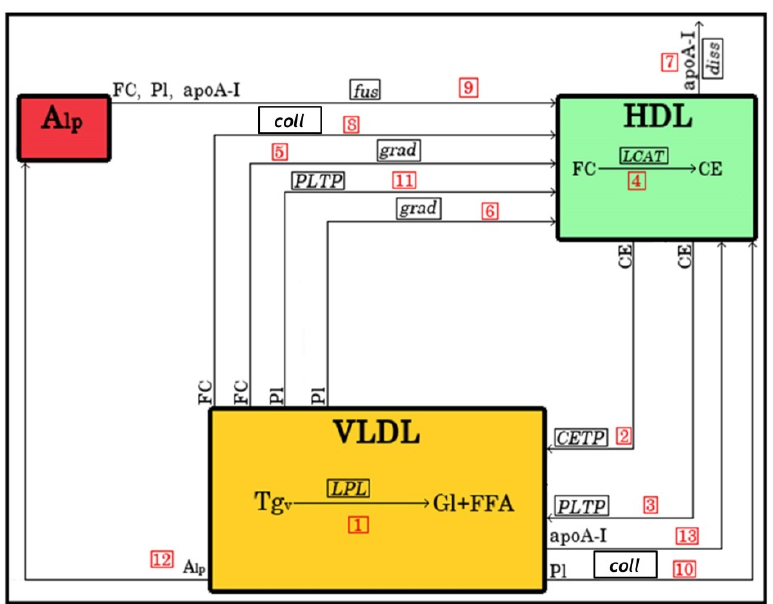
Figure 9. Schematic representation of the model of lipoprotein remodelling upon VLDL lipolysis by LPL in the presence of HDL. The arrows shown represent processes described in the text which are equally abbreviated in italics. The arrows are numbered according to the reaction numbers shown in Table 2. Gl, glycerol; FFA, free fatty acids; grad, gradient; diss, dissociation; coll, collision.